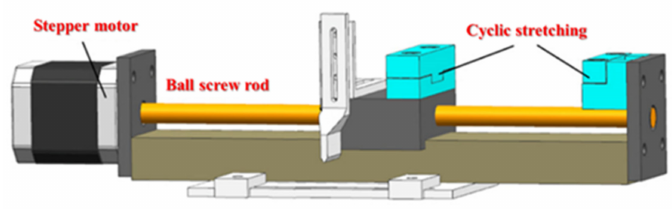
Figure 8. Schematic diagram of the developed tensile-strain